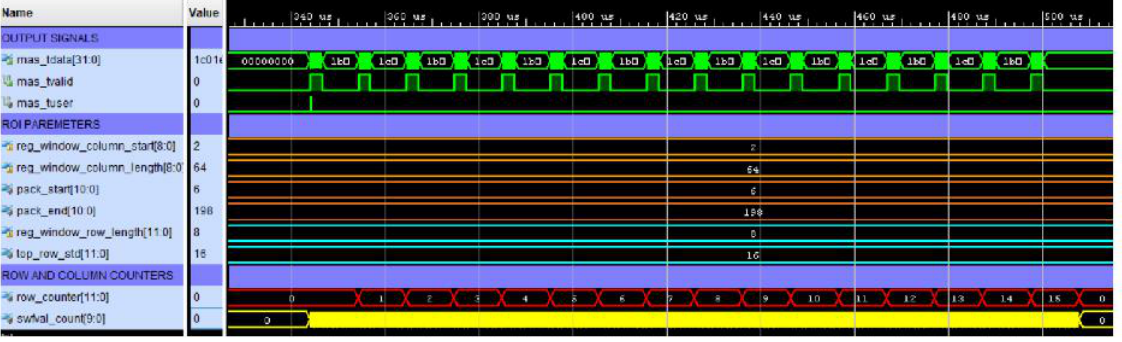
Figure 16. Simulation of the image_tx module for a 16 × 2048 image.